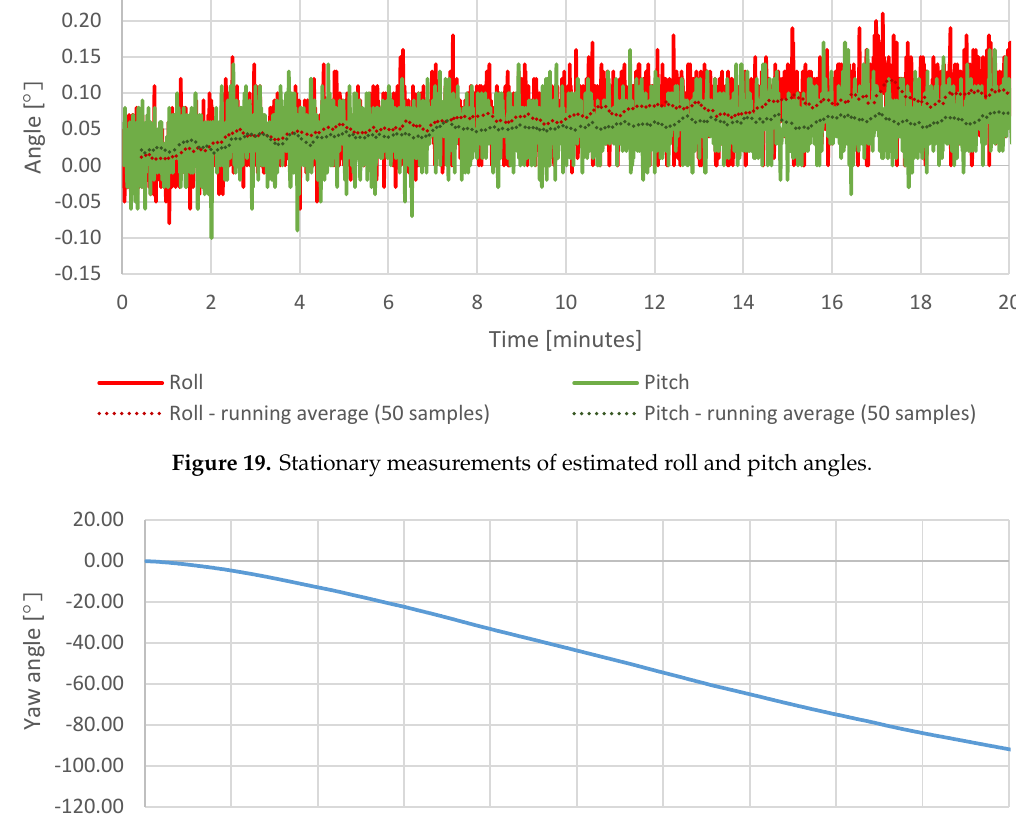
Figure 20. Stationary measurements of estimated yaw angle.